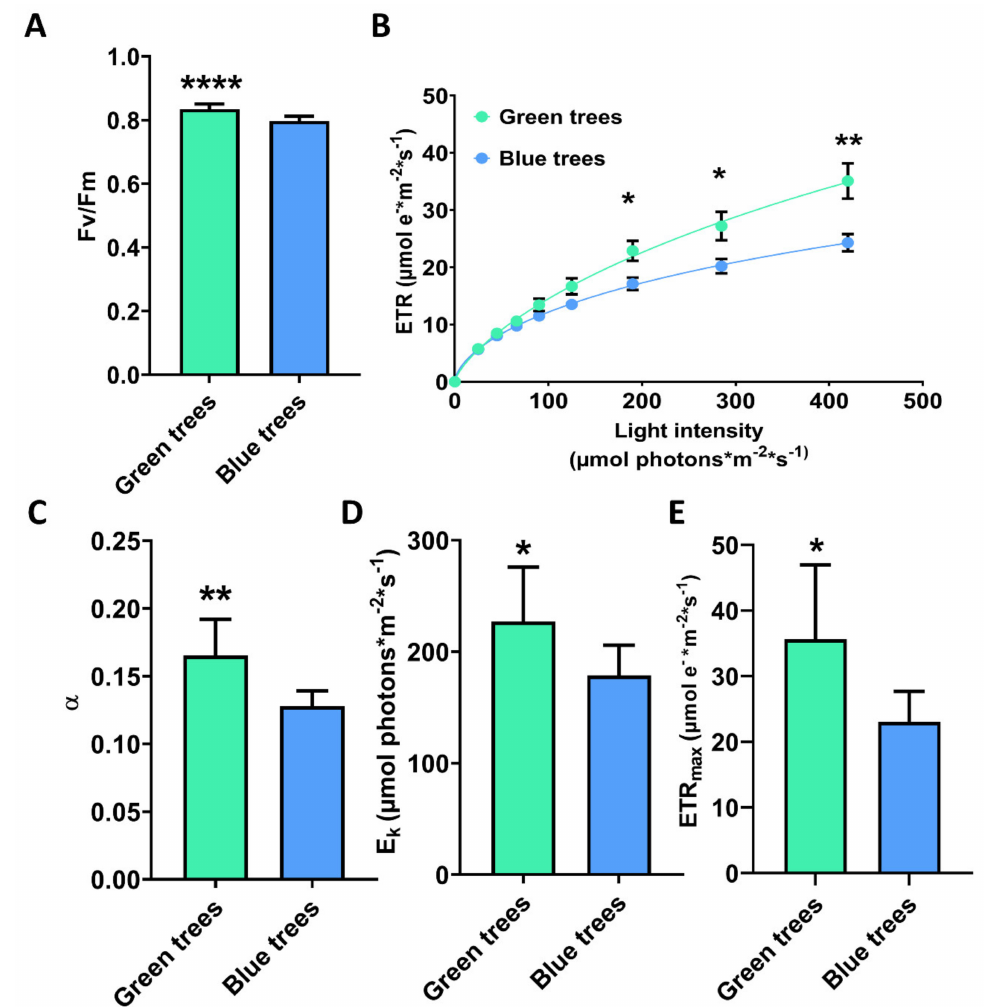
Figure 5. Photosynthesis parameters based on chlorophyll fluorescence analysis. ( A ) Maximum quantum efficiency of photosysytem II (PSII) photochemistry (Fv/Fm). ( B ) Relative electron transport rate (ETR). ( C ) Photosynthetic efficiency ( α ). ( D ) Light saturation index (E k ). ( E ) Maximum electron transport rate (ETR max ). Blue columns correspond to needles from bluish trees. Green columns correspond to needles from green trees. Significant differences were determined with a t -test for each phenotypic needle variation. Asterisks (*) above the columns show significant differences based on: * at p < 0.05; ** at p < 0.01, **** at p < 0.0001. Error bars show SE with n =